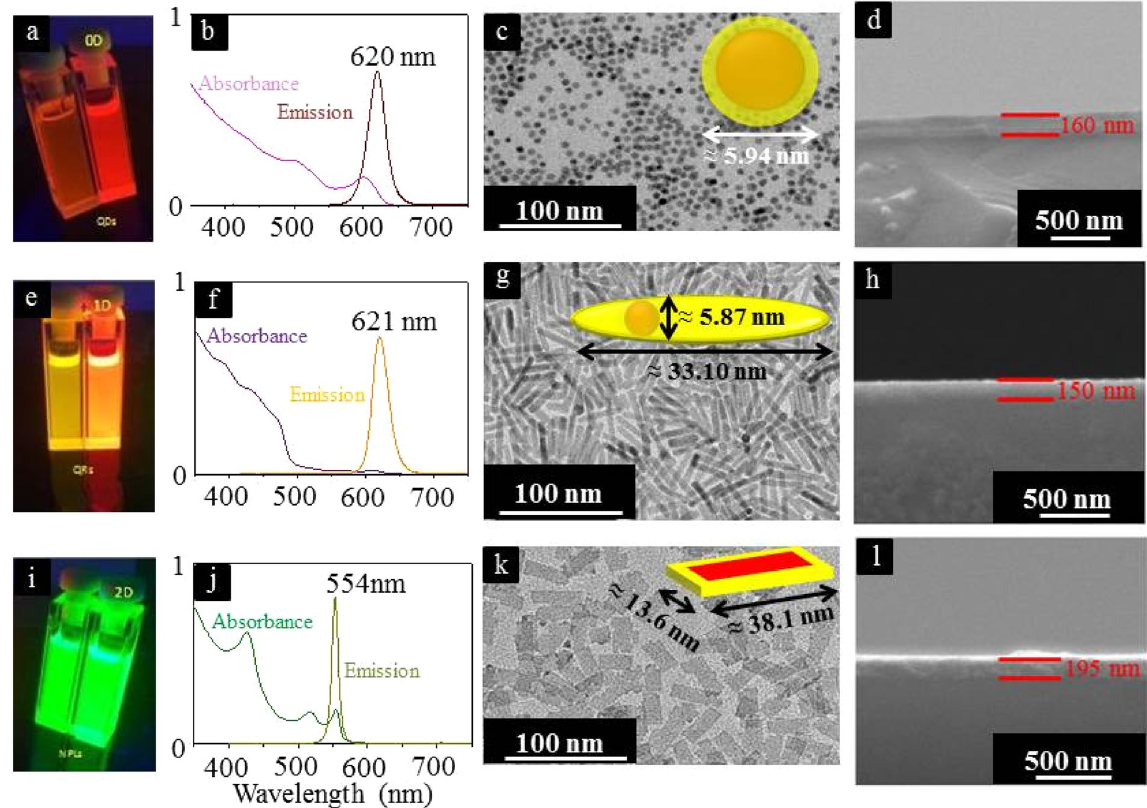
Figure 6. CdS core (left), CdSe/CdS (right) raw materials of core/shell QDs ( a ), core/shell QRs ( e ) and core/ crown NPLs ( i ) respectively. The QDs has an absorption peak at 620 nm ( b ), QRs at 621 nm ( f ) and NPLs at 554 nm ( j ). The TEM image of each particles shows the QDs with a diameter of 5.94 nm ± 0.46 nm ( c ), the QRs, with a diameter of 5.87 nm ± 0.59 nm with length of 33.10 nm ± 2.84 nm ( g ) and the NPLs with a length